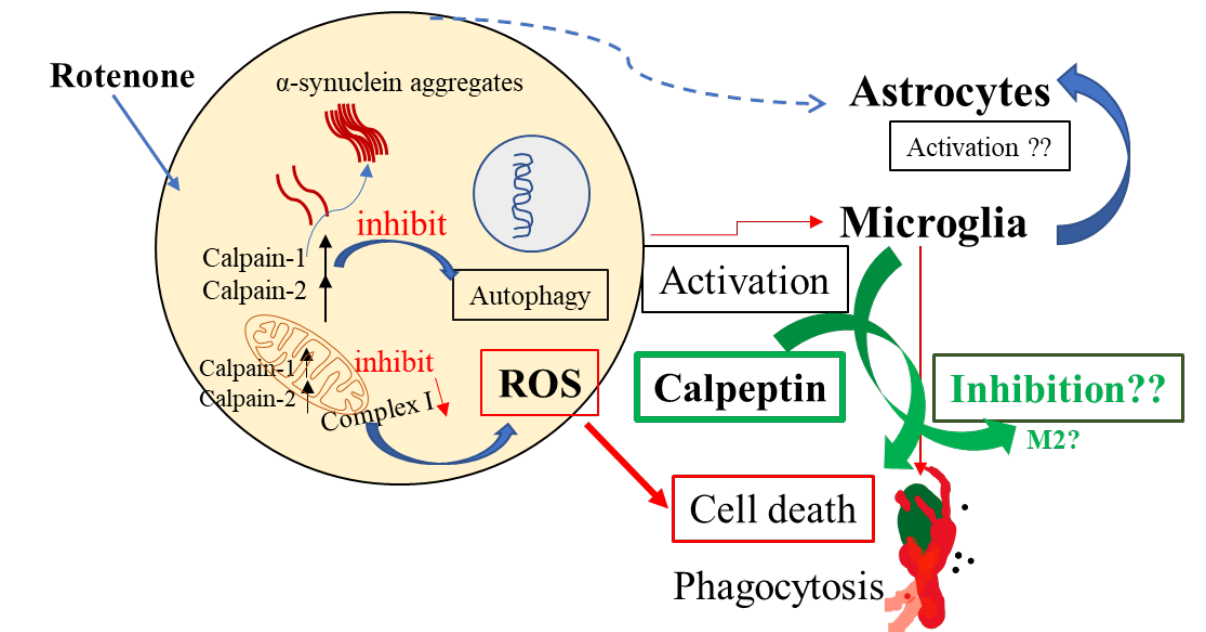
Figure 7. Schematic presentation showing rotenone-induced toxicity in SN neurons. Reactive astrocytes/microglia were detected after rotenone administration in Lewis rats. Both calpain-1 and calpain-2 were also activated in the nigrostriatal pathway following rotenone administration in rats. Calpain inhibition may help reduce glial activation via reduction of ROS and differentiation of microglia into M2-type cells. Decreased phagocytic function of glia and selective autophagy may also support preferential regulation of calpain-1 and calpain-2 expression/activity and the fate of neu- ronal survival in PD.